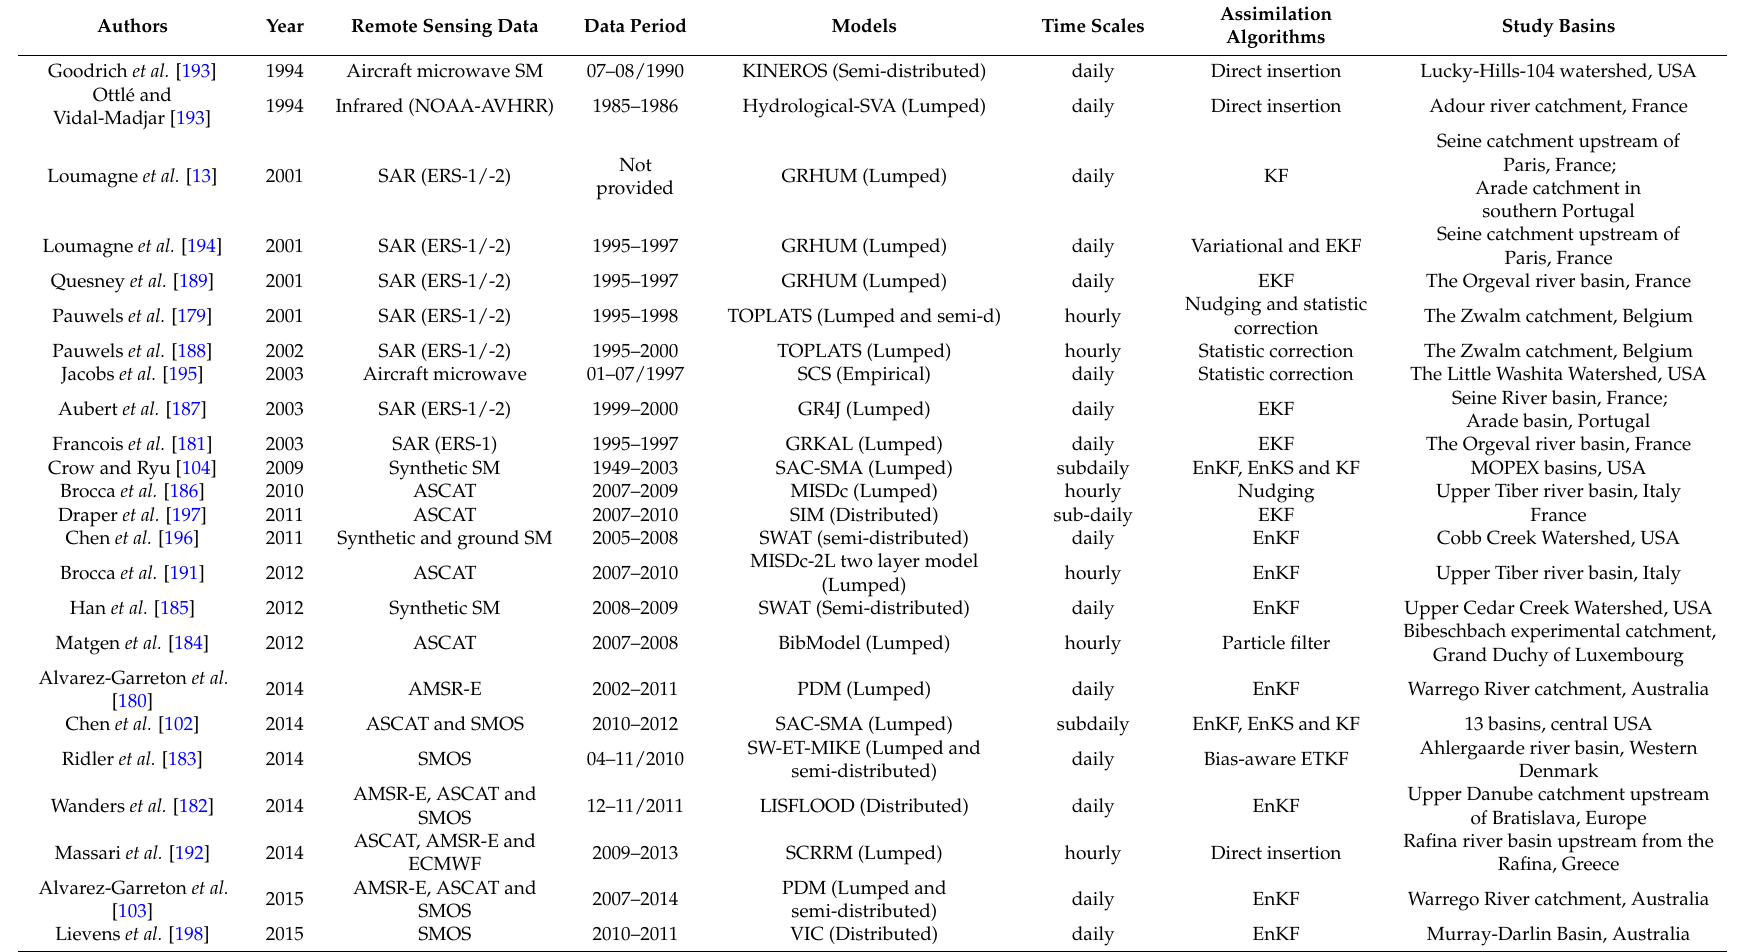
Table 4. Studies assimilating remotely sensed soil moisture data into flood forecasting